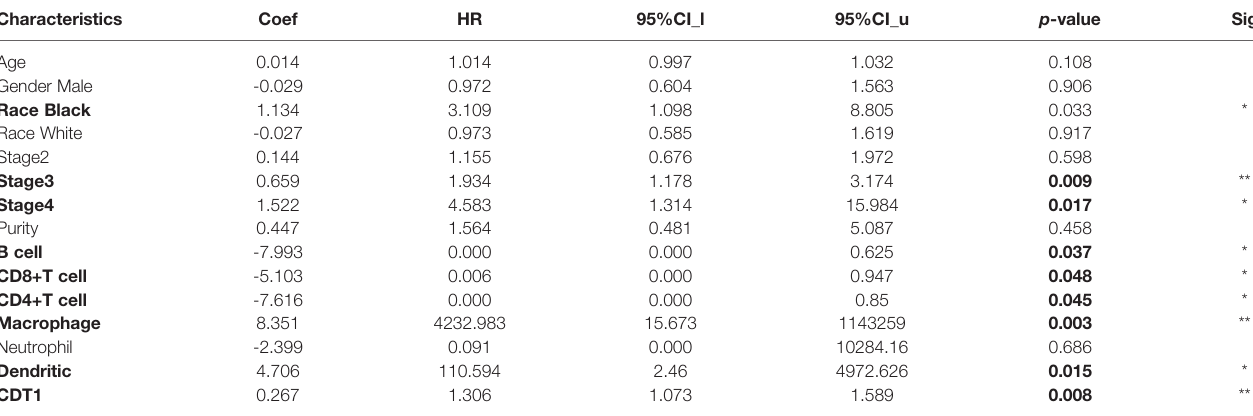
TABLE 3 | The Cox proportional hazard model of CDT1 and six tumor-in fi ltrating immune cells in HCC.